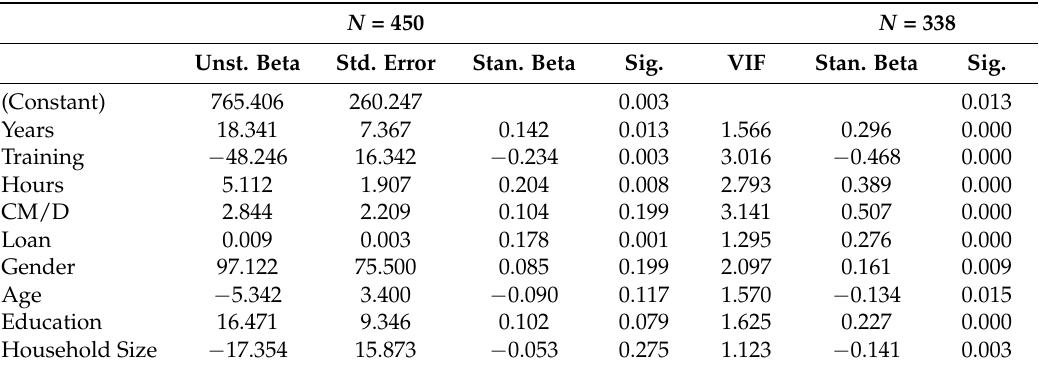
Table 7. Regression